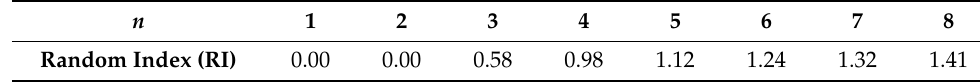
Table 14. Random Consistency Index—adapted from [28].